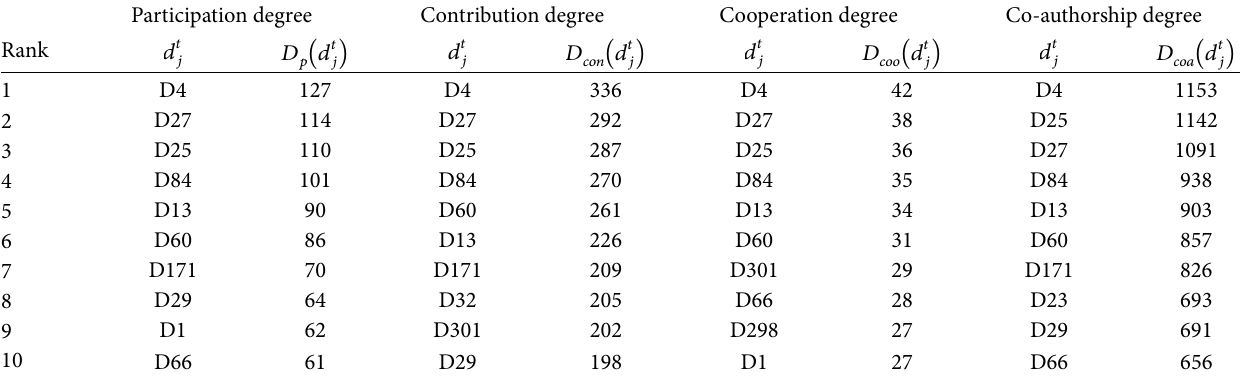
11: The top ten drafters with high indicators in LTE system.